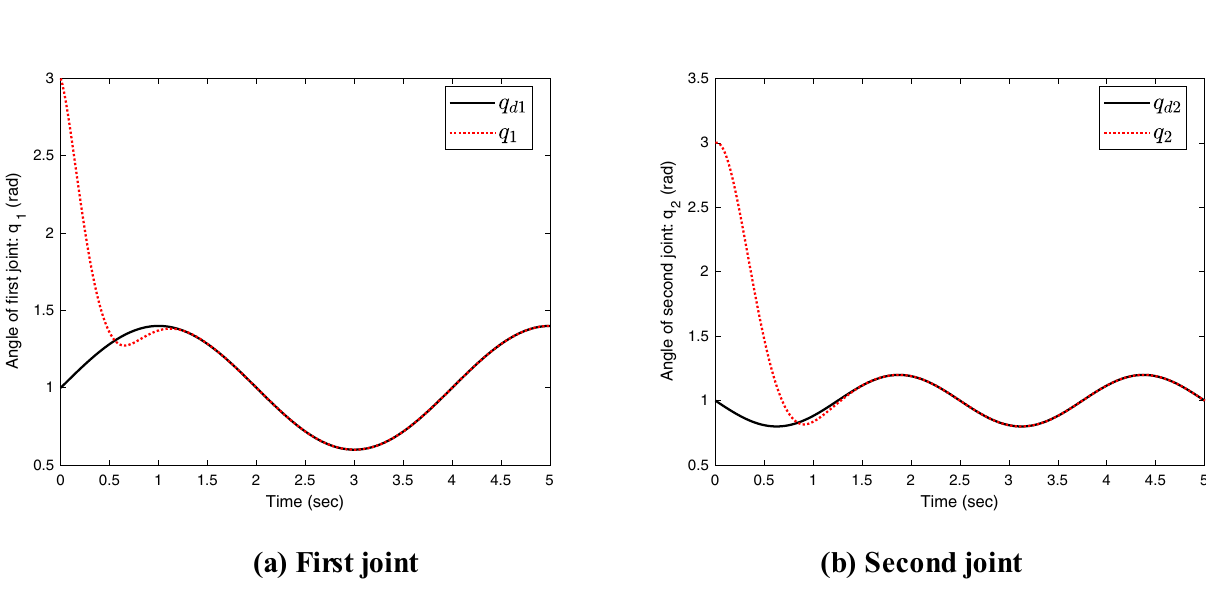
Fig. 5 Plots of positions q d 1 , q 1 of first joint and q d 2 , q 2 of second joint (SOSMC)